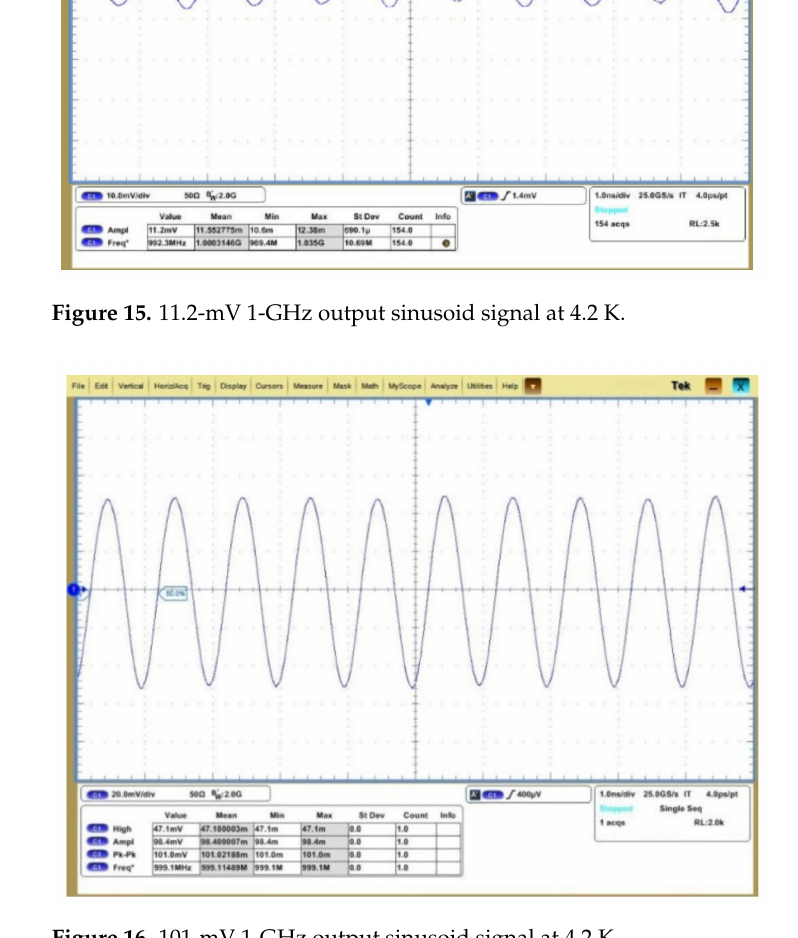
Figure 16. 101-mV 1-GHz output sinusoid signal at 4.2 K. Table 1. Comparison with state-of-the-art cryogenic